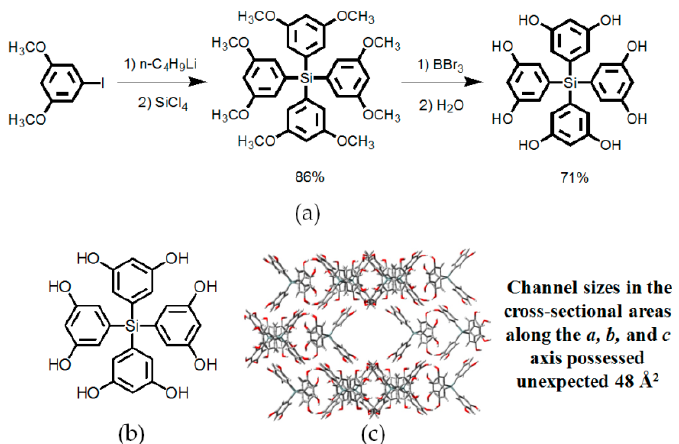
Figure 4. ( a ) Synthetic strategy of the building motif 2 ; ( b ) Structure of the building motif 2 ; ( c ) Crystalline packing structure of the porous network of H2 .